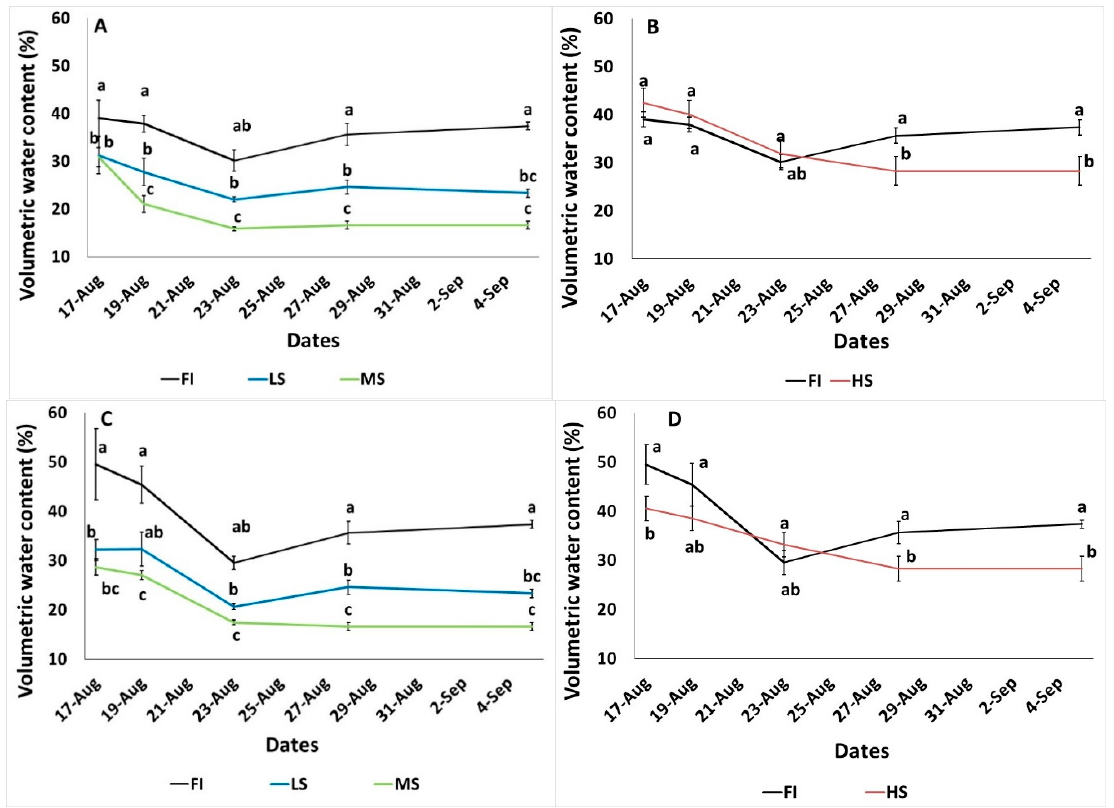
Figure 1. Impact of short-term drought and heat stress on soil volumetric water content in two grapevine cultivars, Chardonnay ( A,B ) and Xynisteri ( C,D ). Vegetative cuttings from both cultivars grown in pots were submitted to full irrigation (FI); light water stress (LS) with 80% of the FI, moderate water stress (MS) with 50% of the FI, and heat stress (HS). Data are means ± SE ( n = 4), and significant differences ( P < 0.05) among treatments for the different dates are indicated by different letters (a, b, c, ab, bc).